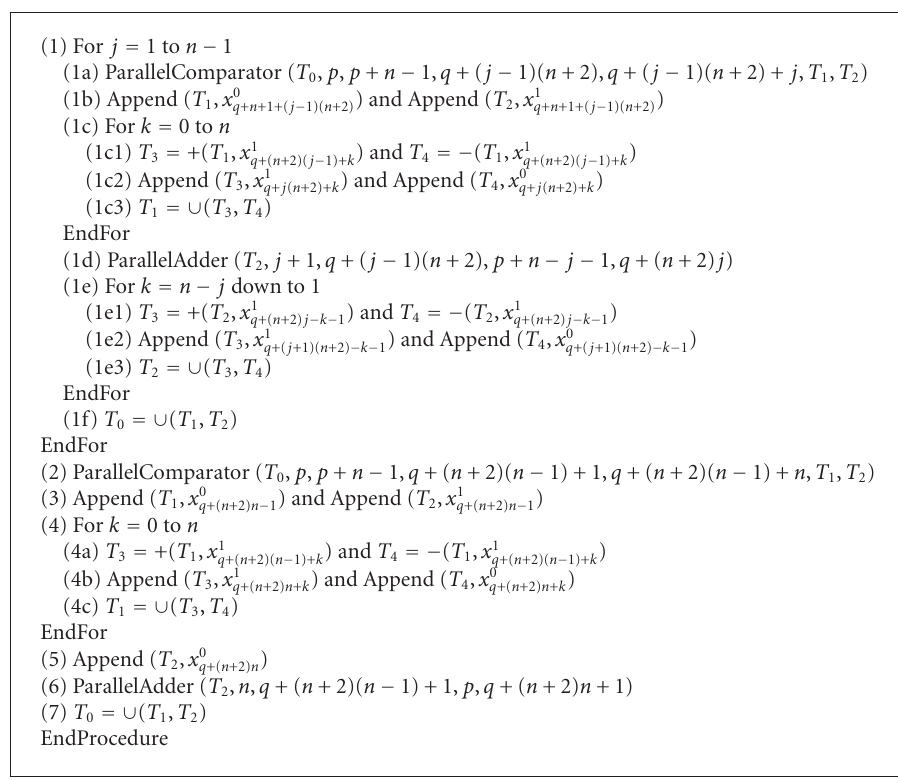
Algorithm 3: Procedure SimilarDiv ( T 0 , n , p , q